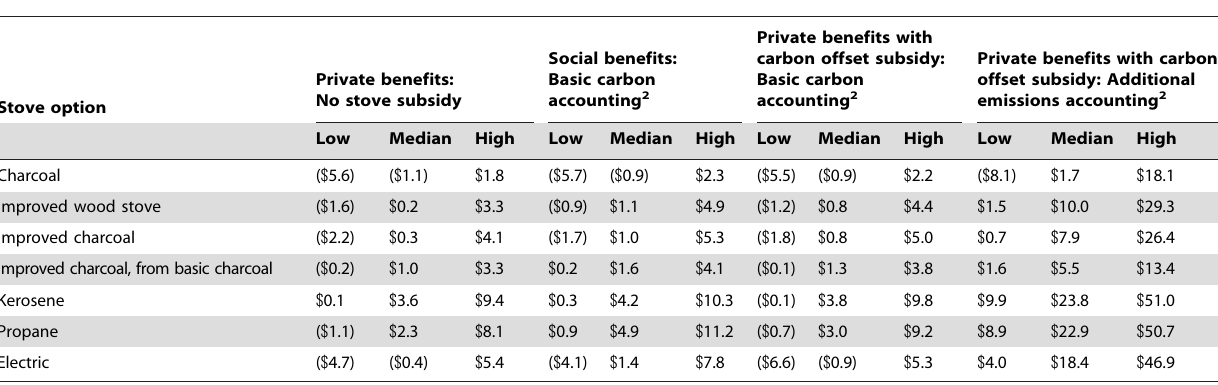
Table 4. Ranges of private net benefits of different stove options (relative to traditional wood-burning stoves, except for charcoal as indicated) as a function of the amount of capital subsidy, and ranges of overall social benefits (All in $ /hh-month; parentheses indicate negative outcomes). 1